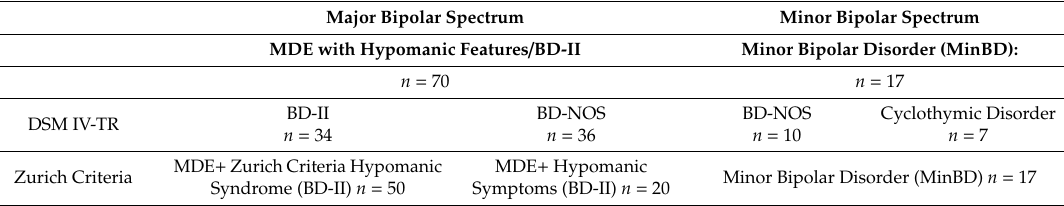
Table 2. Diagnoses according to Diagnostic and Statistical Manual of Mental Disorders-IV-Text Revision (DSM-IV-TR) and Zurich criteria.